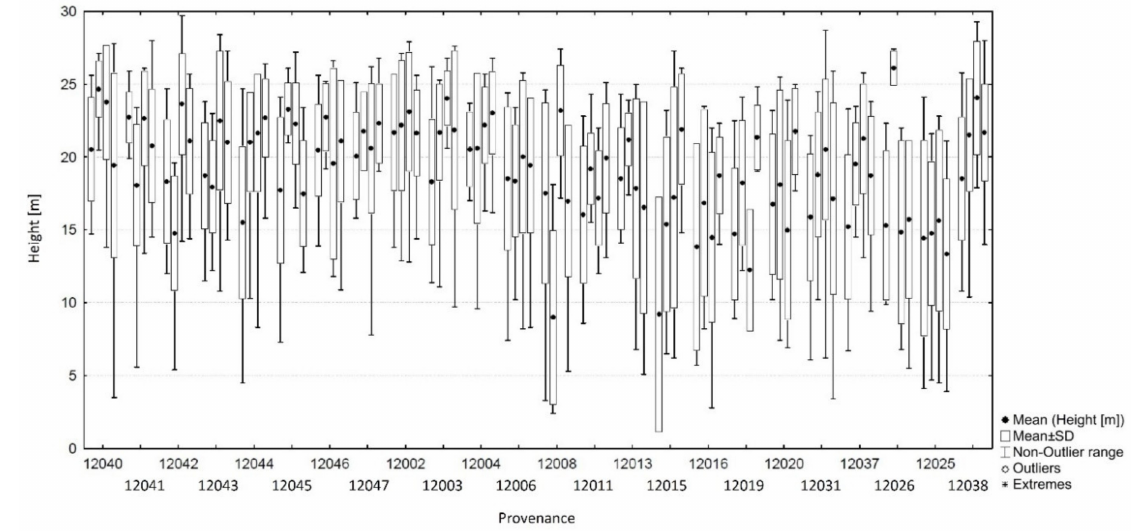
Figure A8. Box plot of height variation statistics by replications and by provenance in the trial Zbiroh. The provenances are sorted by geographic position (compare Figure A5).